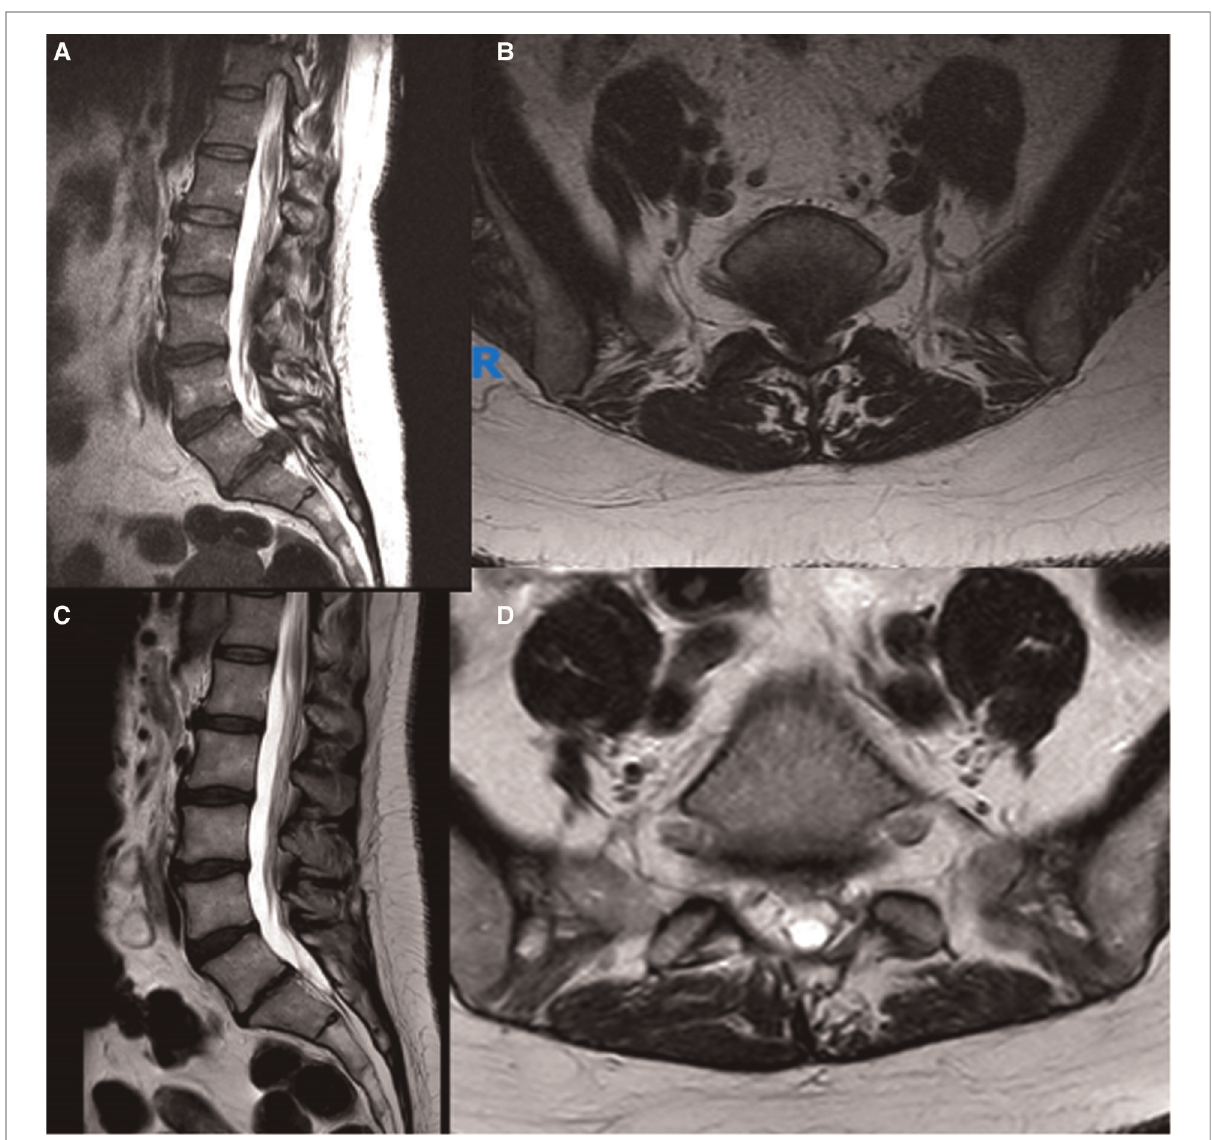
FIGURE 1 Preoperative ( A,B ) and postoperative ( C,D ) sagittal and axial MRI images of a typical patient diagnosed with an CES due to a giant L5-S1 disc herniation and operated by